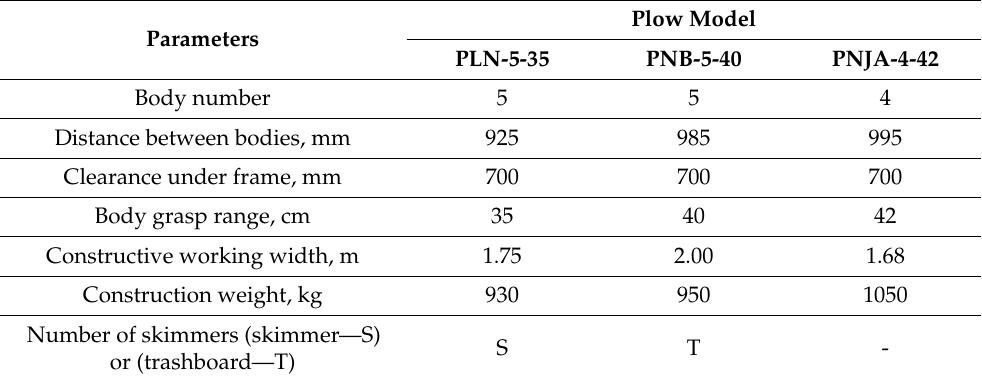
Table 2. Technical specifications of the compared plow models.